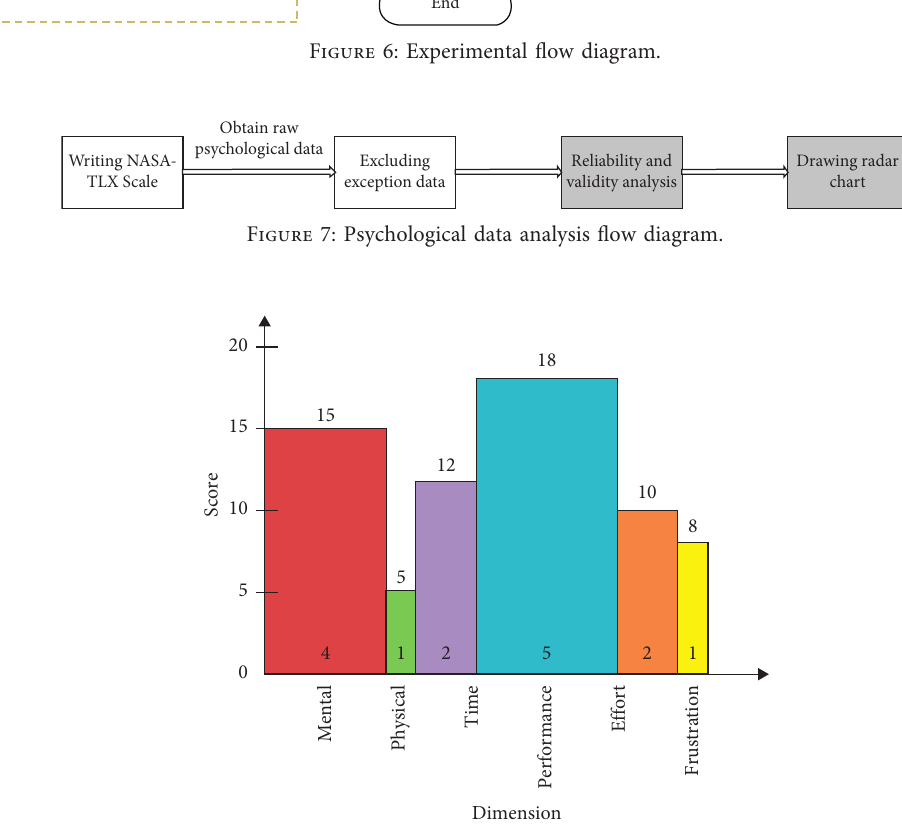
Figure 8: NASA-TLX score data chart.